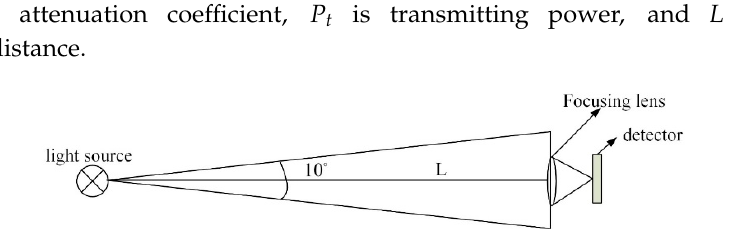
Figure 6. optical signal transmission model of underwater optical communication. Figure 6. Optical signal transmission model of underwater optical